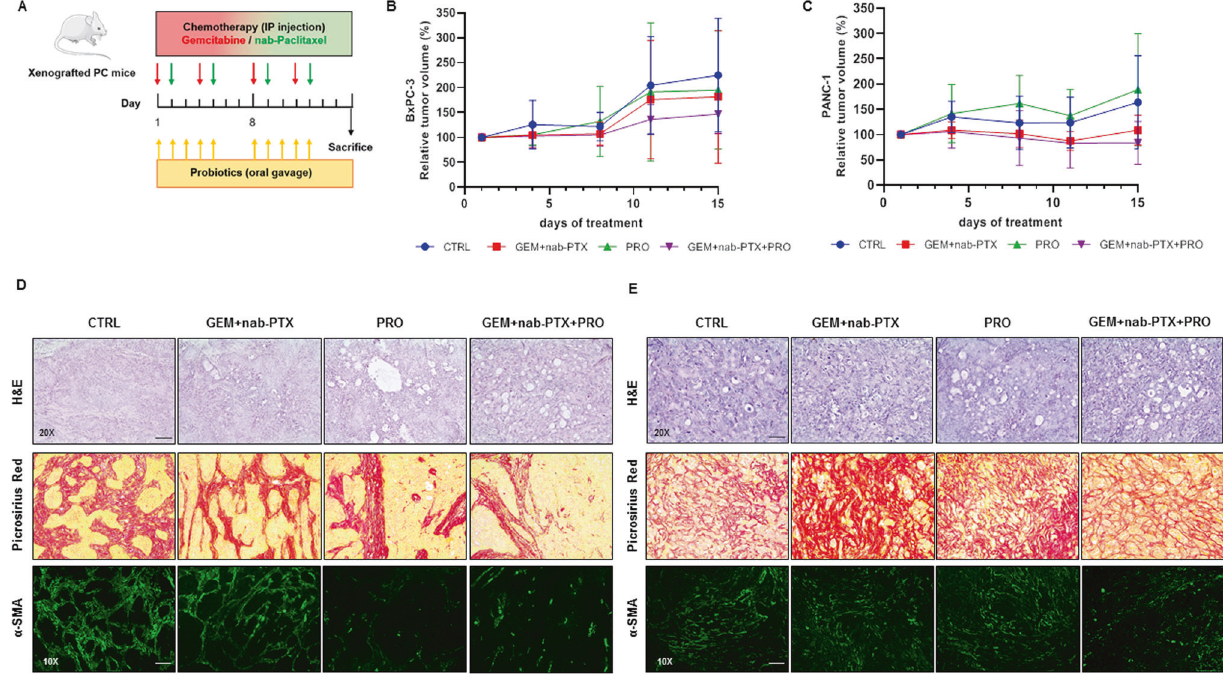
Fig. 1 Impact of chemotherapy and/or probiotic treatment on mice pancreatic cancer growth and histology. Scheme of the treatment with Gemcitabine + nab-Paclitaxel and/or probiotics in xenografted pancreatic cancer mice ( A ). Growth curves obtained by measuring tumor volumes in BxPC-3 ( B ) and PANC-1 ( C ) bearing mice belonging to the different experimental groups. Data of relative tumor volumes are shown as mean ± SD. Representative histological stain of H&E (20X magni fi cation), Picrosirius Red (×20 magni fi cation) and α -SMA (×10 magni fi cation) in BxPC-3 ( D ) and PANC-1 ( E ) tumor sections. Scale bar 50